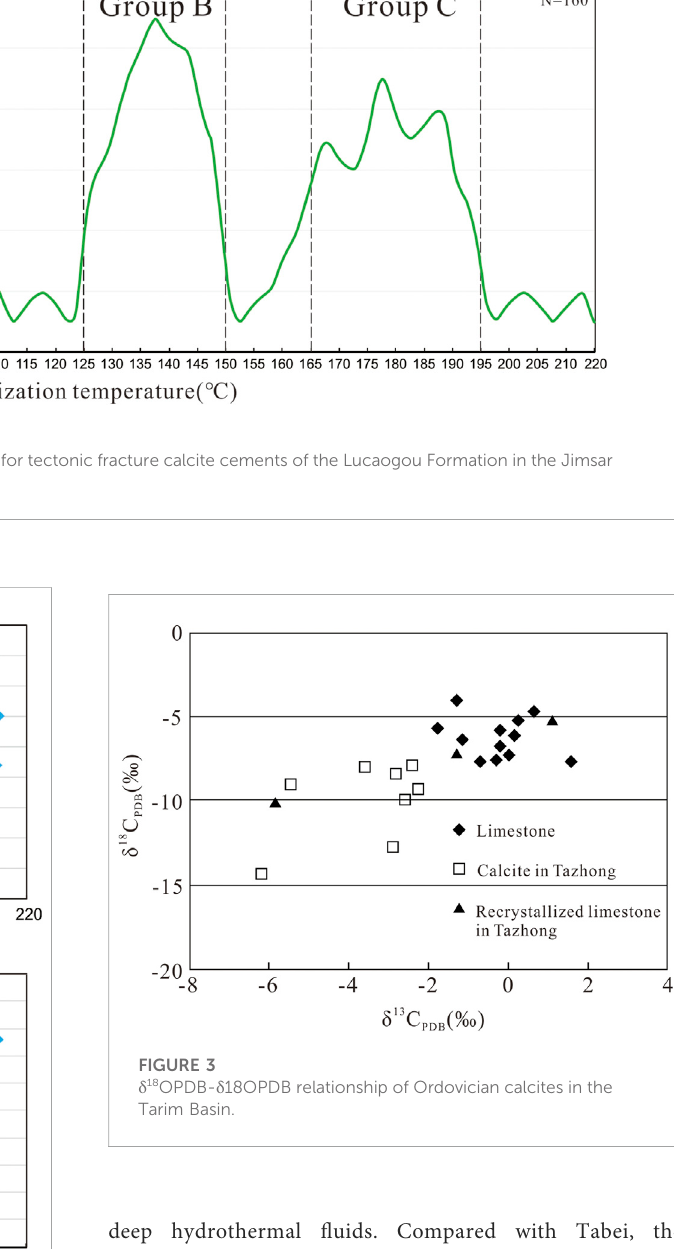
deep hydrothermal fl uids. Compared with Tabei, the Ordovician calcite samples from Tazhong were found with fl uid inclusions at higher homogenization temperatures and salinity, as the homogenization temperatures (139.2 – 180.8 ° C) were higher than the burying temperatures of strata, indicating the cause of being deep hydrothermal fl uids (Figure 3). In conclusion, theoretically, the homogenization temperatures of fl uid inclusions from deep fl uid active areas are higher than the stratum temperatures.